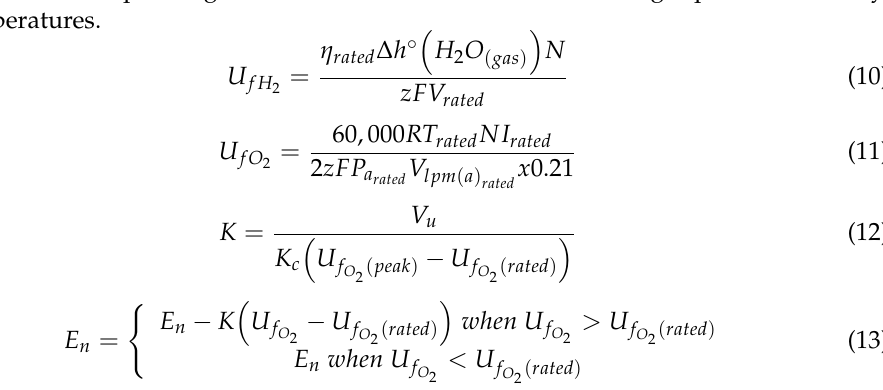
Voltage and O 2 utilisation vs. time are represented in Figure 4 ( a ) and ( b ), respectively [19].